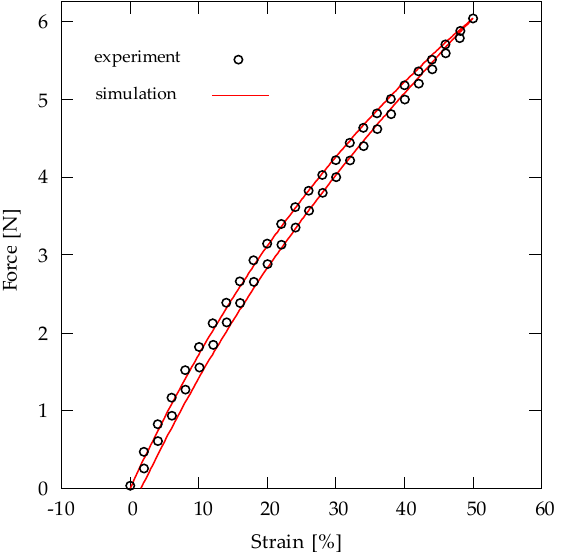
Figure 10. Experimental data and simulation results for strain–force relation of the loading–unloading test with a strain rate 𝜖(cid:4662) = 0.1 s − 1 .